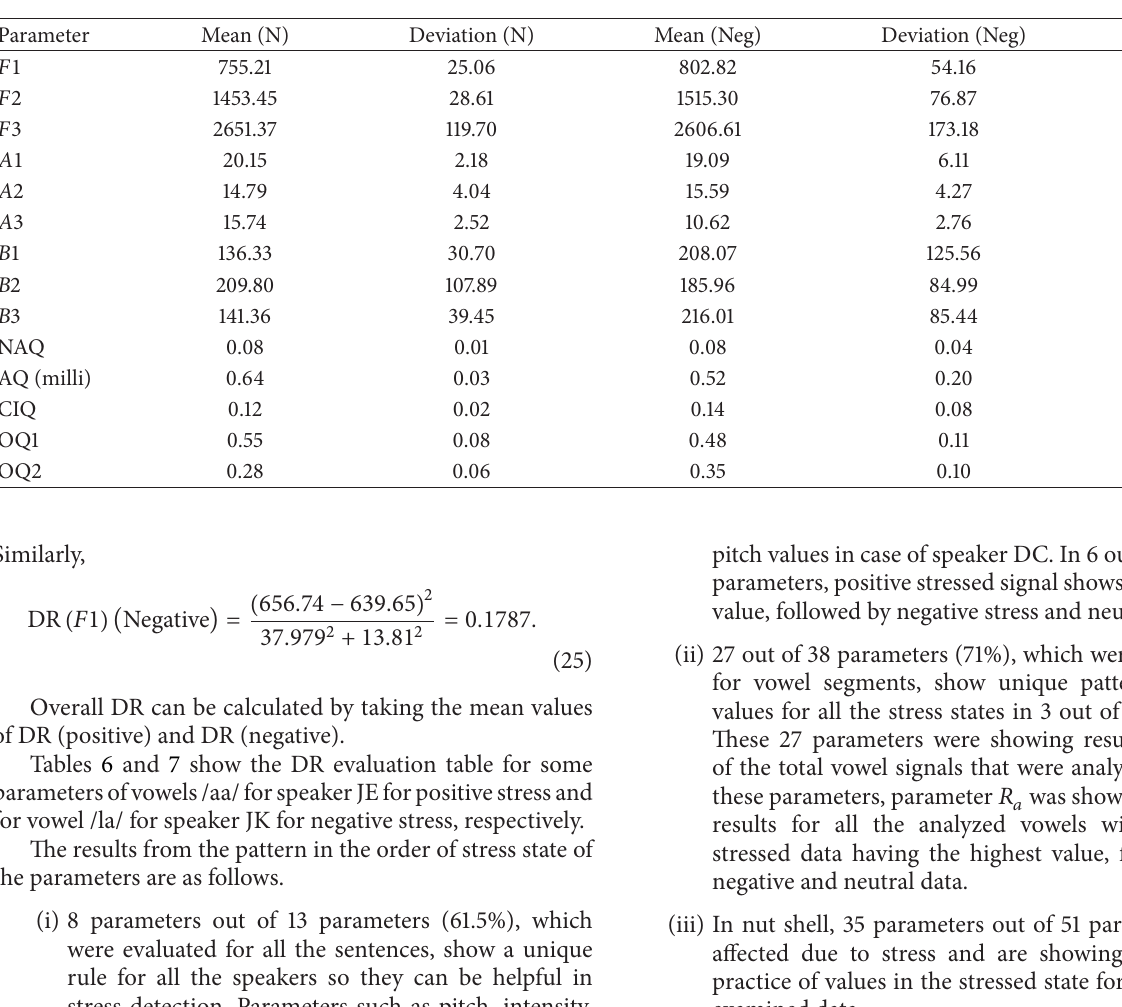
plotted. Figure 14 shows the distribution function of